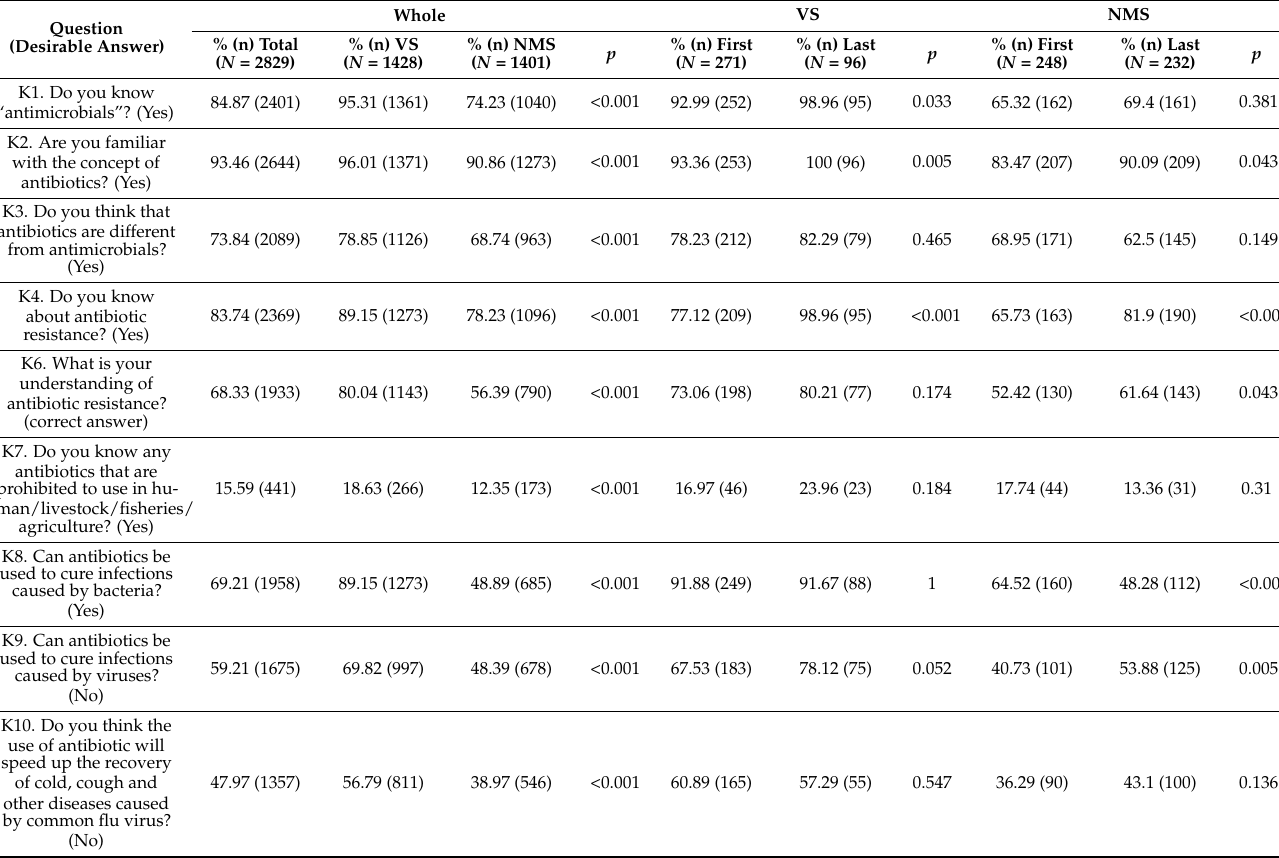
Table 3. Proportion of responses to questions about